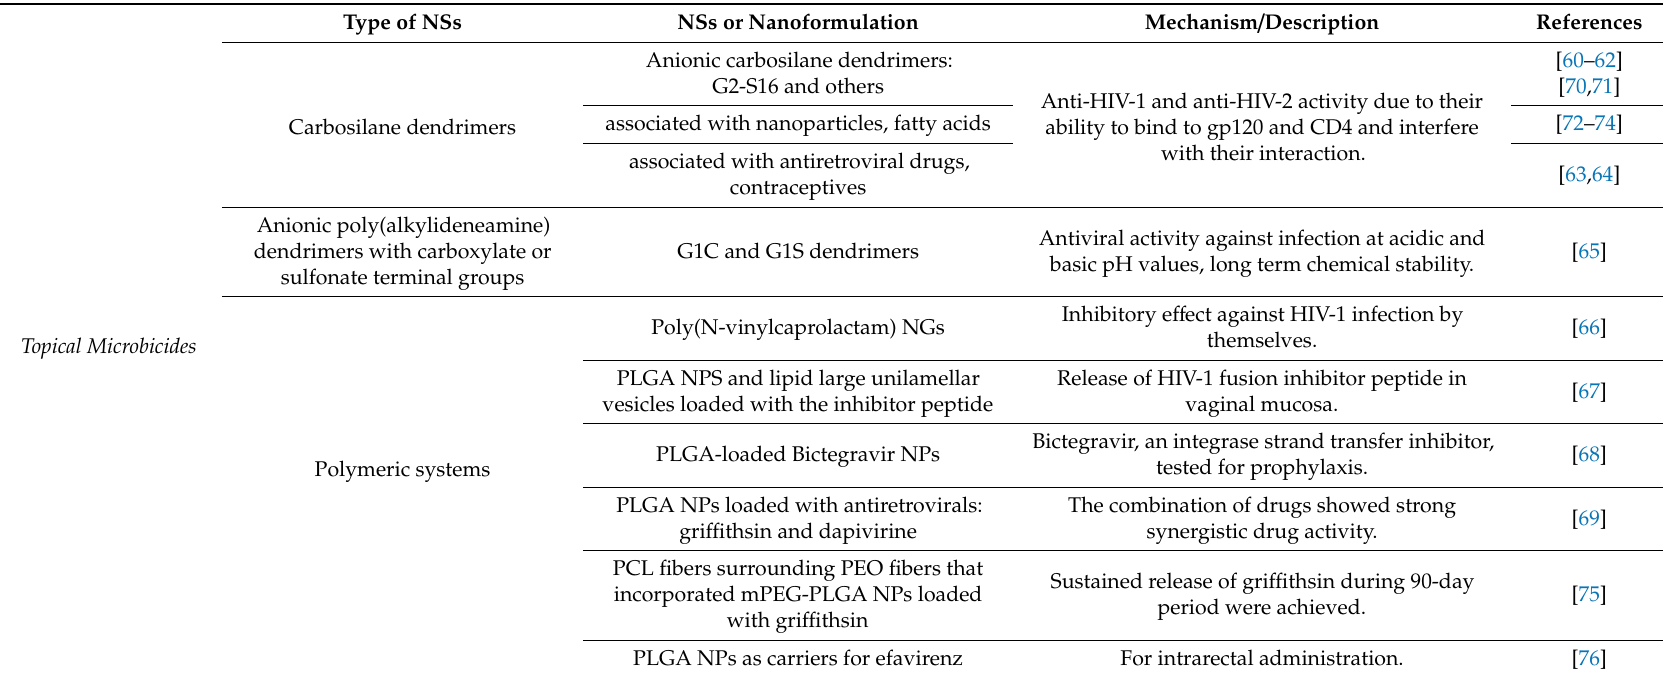
Table 2. Nanotechnology approaches for HIV